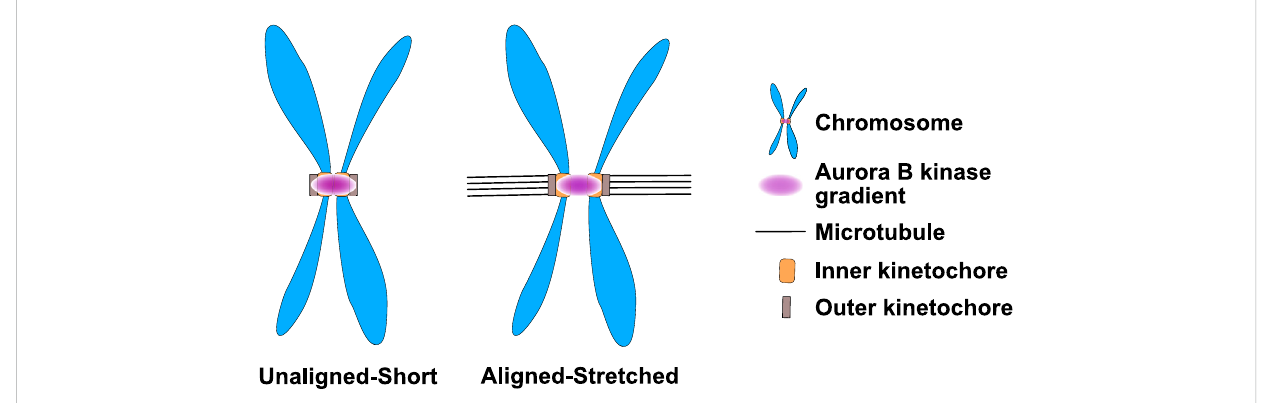
FIGURE 7 Aurora B kinase may form small kinase gradients at the inner centromere of prometaphase/metaphase chromosomes that differentially phosphorylate kinetochores depending upon their kinetochore-microtubule attachment status. Aurora B kinase in prometaphase and metaphase is localized to the region between kinetochores known as the inner centromere. It has been proposed that Aurora B generates gradients of activity from inner centromeres. The inner centromeric chromatin has spring like activities and is stretched when kinetochores make attachments because the microtubulesgenerateanoutwardforce.Thus,kinetochoresinunattachedchromosomeswouldbeinahigherAurorakinasestatethanthekinetochores that make attachments. Figure representation: Chromosome arms, blue; Inner-kinetochores, orange rectangles; Outer-kinetochore, grey rectangles, Microtubules K- fi bers, Black lines; Aurora B kinase activity gradient at the inner centromere,